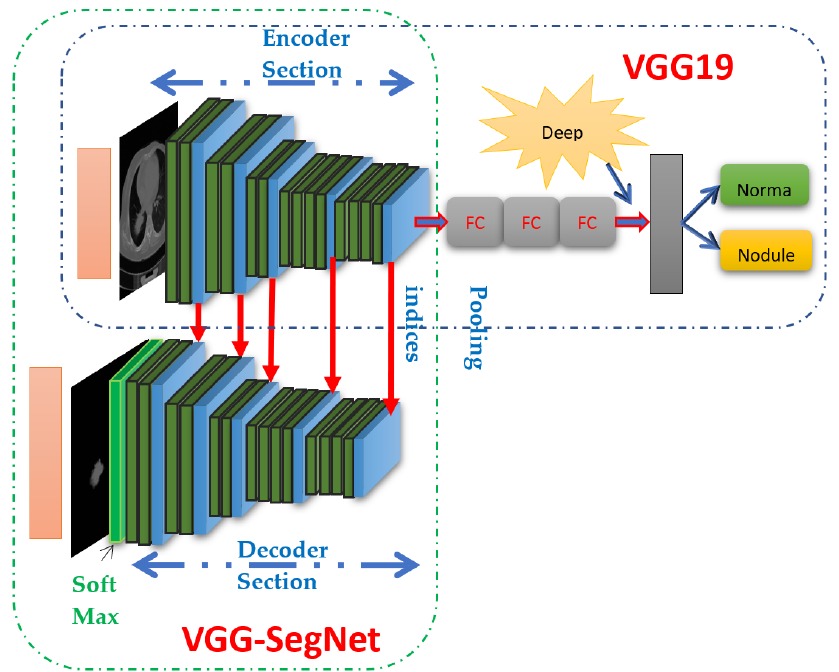
Figure 3. Structure of VGG19 supported segmentation (VGG-SegNet) and classification scheme.